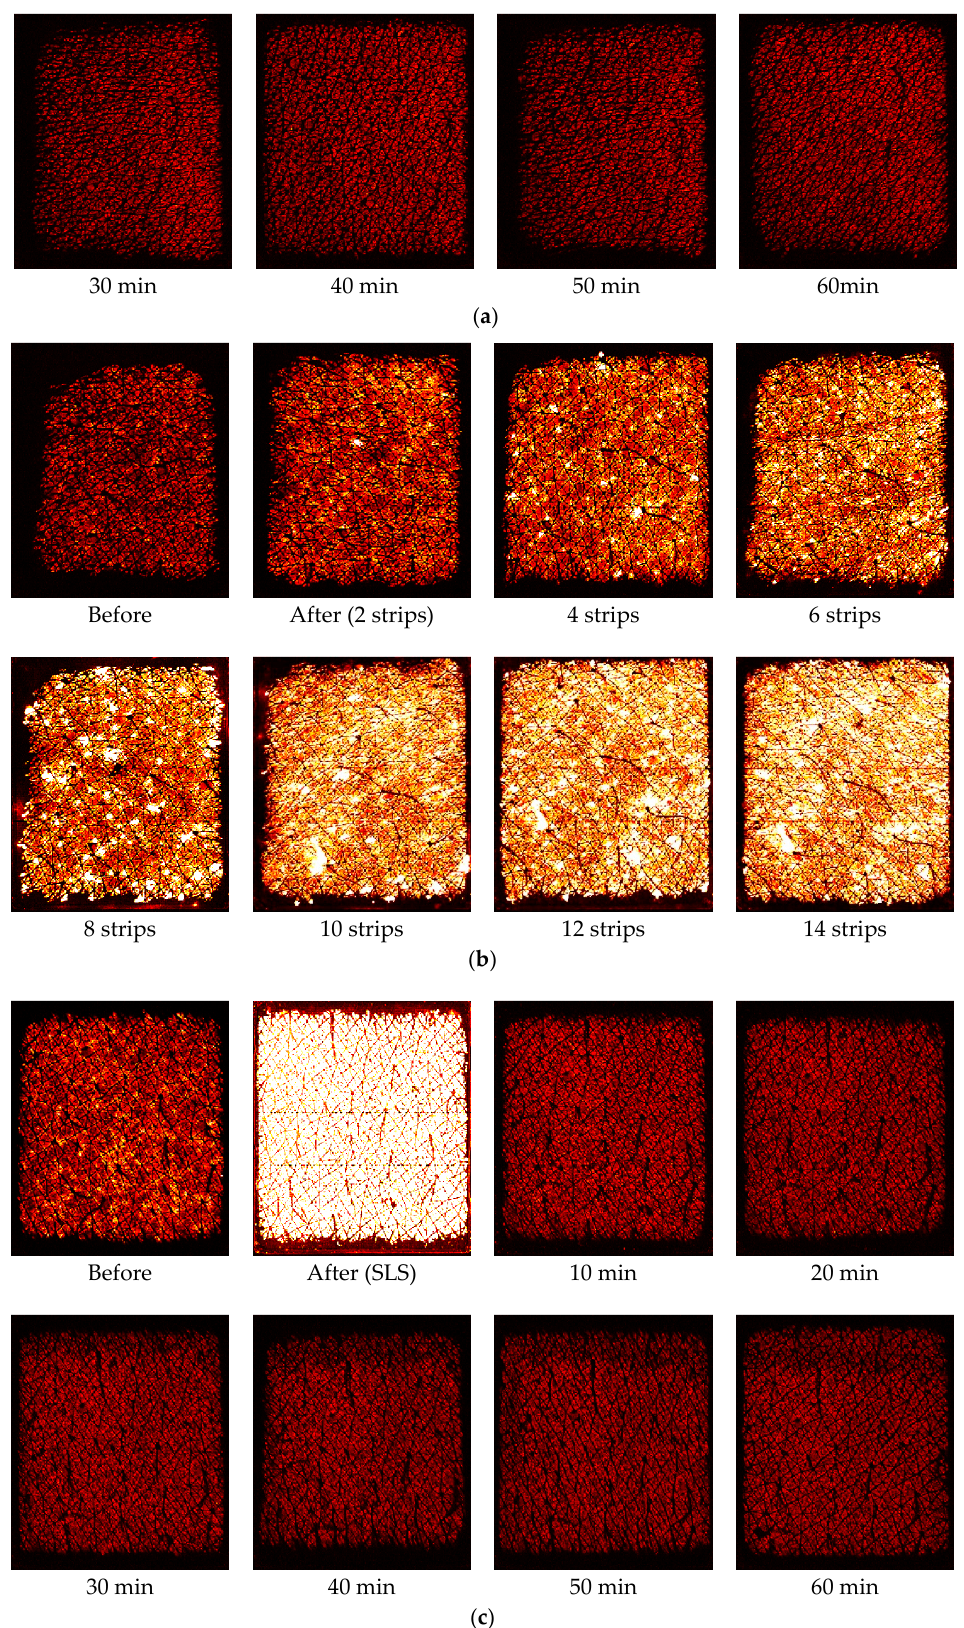
Figure 5. Typical capacitive contact images of before and after intensive washes ( a ); tape stripping ( b ); SLS irritation ( c ).